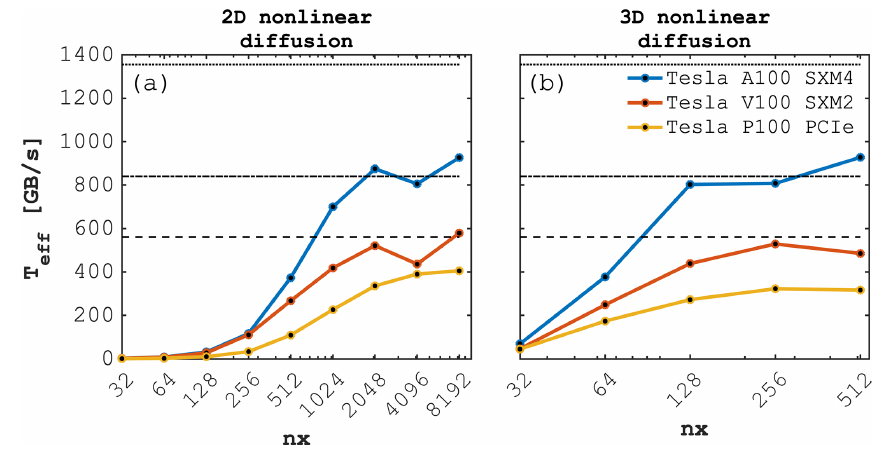
Figure 9. Effective memory throughput T eff [GBs − 1 ] for the (a) 2D and (b) 3D nonlinear diffusion Julia GPU implementations using ParallelStencil.jl executed on various NvidiaGPUs (Tesla A100 SXM4, Tesla V100 SXM2 and P100 PCIe). The dashed lines report the measured peak memory throughput T peak (1355GBs − 1 Tesla A100, 840GBs − 1 Tesla V100, 561GBs − 1 Tesla P100) one can achieve on a specific GPU architecture, which is a theoretical upper bound of T eff .